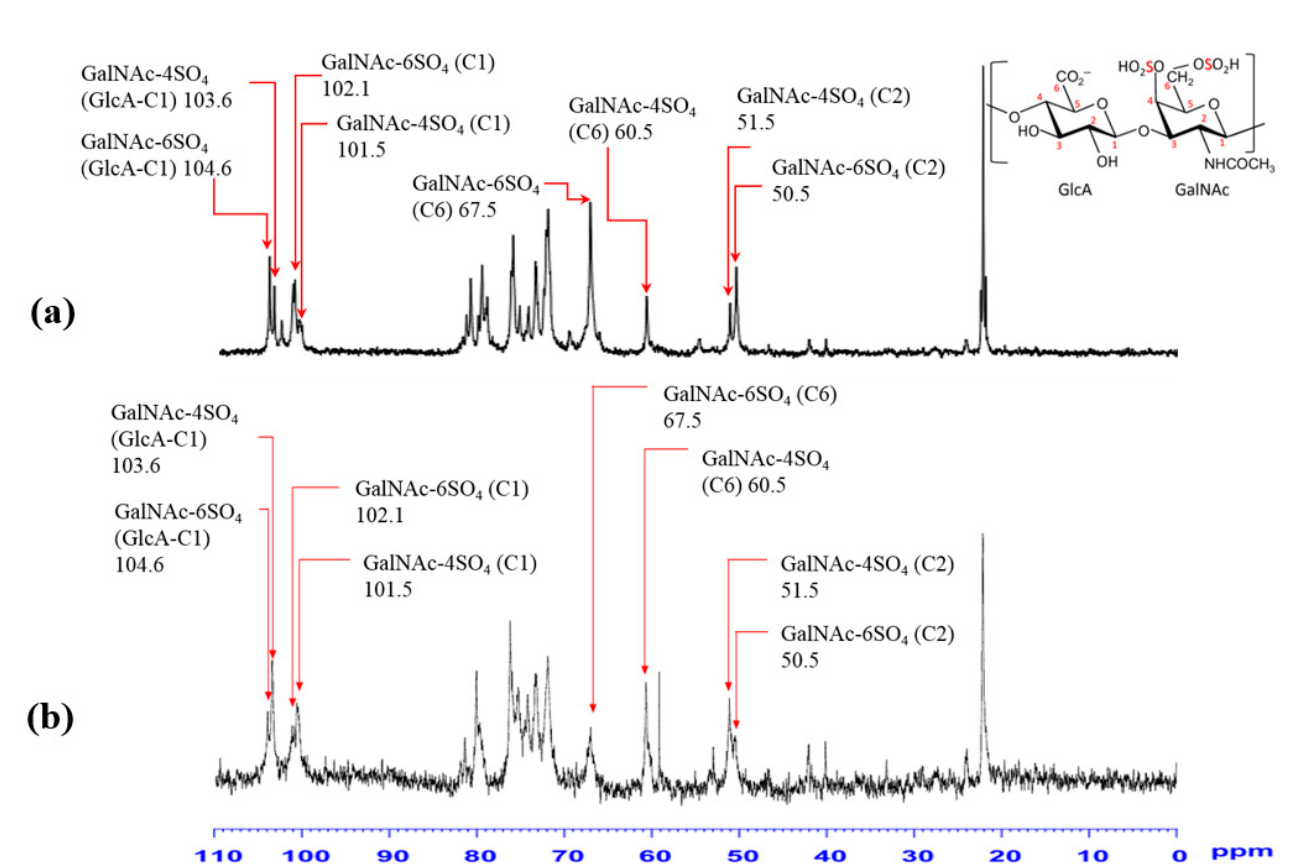
Figure 8. 13 C NMR spectrum of ( a ) ChS standard and ( b ) purified jumbo squid ChS measured at 600 MHz.